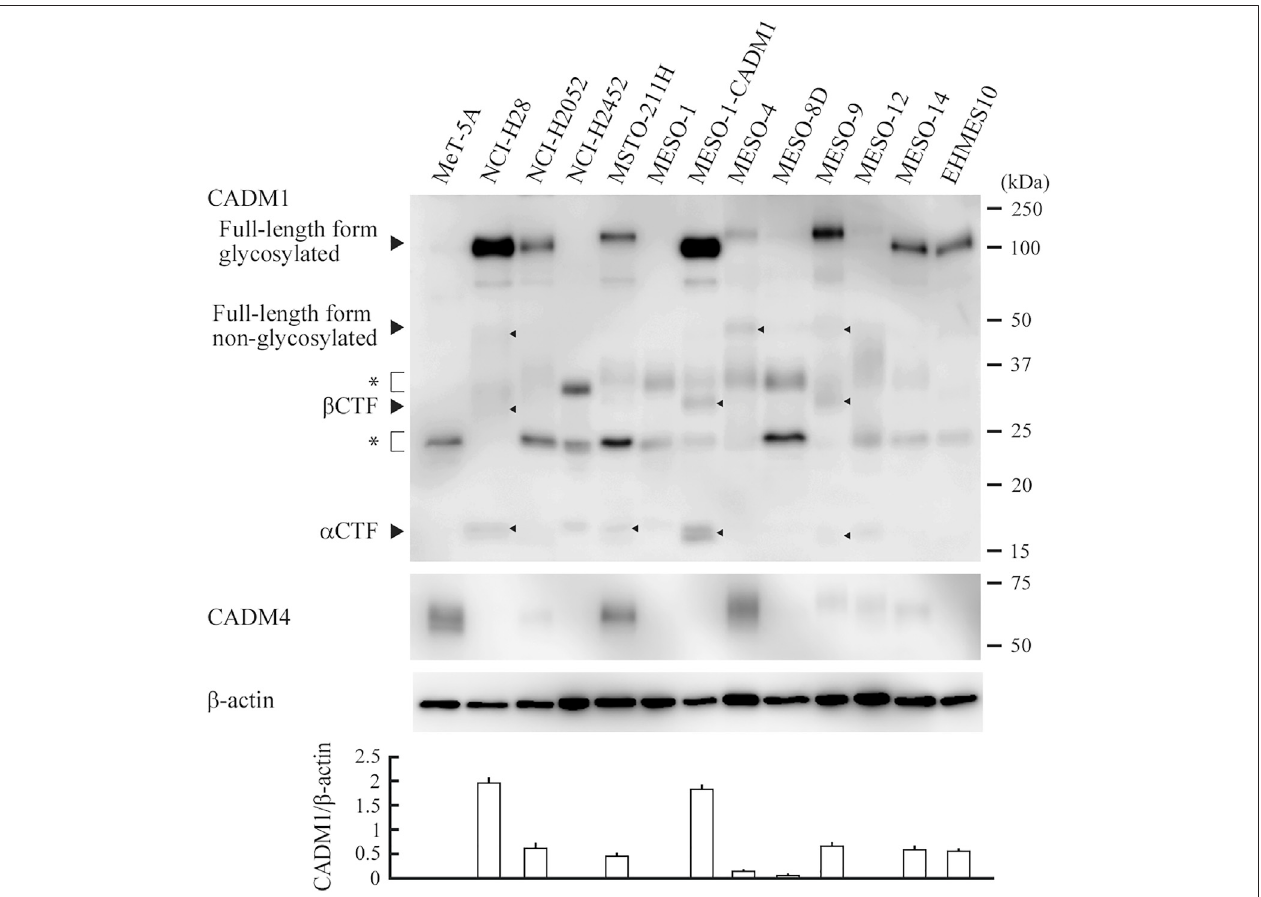
FIGURE 1 | CADM1 protein expression in MPM and mesothelial cell lines. Cell lysates of twelve human MPM cell lines indicated and one mesothelial cell line MeT- 5A were blotted with an anti-CADM1 C-terminal antibody (upper). Arrowheads depict various forms of CADM1; full-length forms glycosylated and non-glycosylated, C-terminal fragments generated by α - and β -ectodomain shedding ( α CTF and β CTF). Asterisks indicate non-speci fi c bands caused by the secondary antibody. After stripping, the blot was reprobed with antibodies against CADM4 (middle) and β -actin (lower) to indicate the expression of a heterophilic binding partner and the amountofprotein loadingper lane,respectively.Expressionlevelsoftheglycosylated full-lengthformrelativeto β -actinareplottedinabar graphatthebottom. Foreach cell line, the mean value of three independent experiments is plotted with a thin line indicating the standard deviation, which is often too small to be shown by a line.